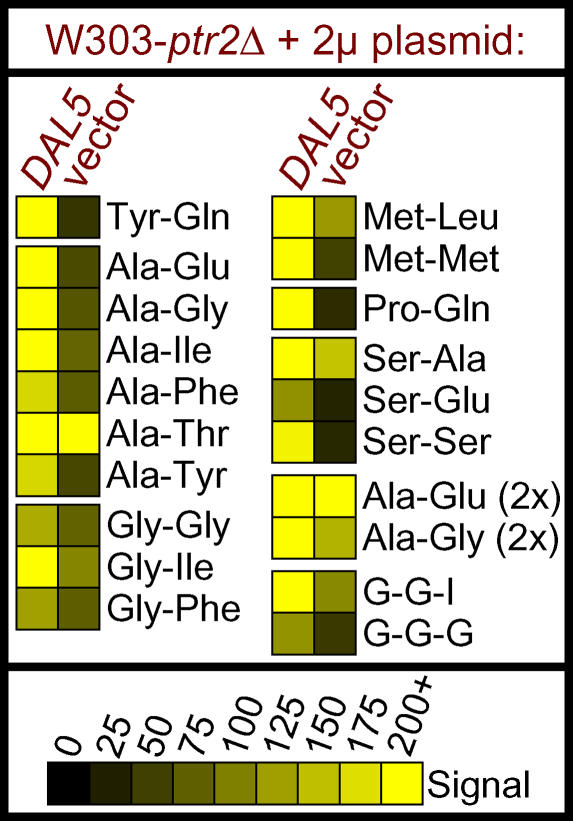
Utilization of a Subset of Dipeptides Is Enhanced in W303-ptr2Δ upon Overexpression of DAL5
Strain W303-ptr2Δ was transformed with either the vector pRS426 or the plasmid pRS426-DAL5, a 2-μm plasmid containing a genomic fragment including DAL5, and phenotyped using the PM assay. The nitrogen sources shown comprise all instances in which the signal values met our reliability criteria (see Figure 2) and the presence of pRS426-DAL5 altered the signal value by more than 50 units relative to the vector control. Dipeptides followed by “(2×)” are present in the PM assay plates at twice the concentration of the other dipeptides.